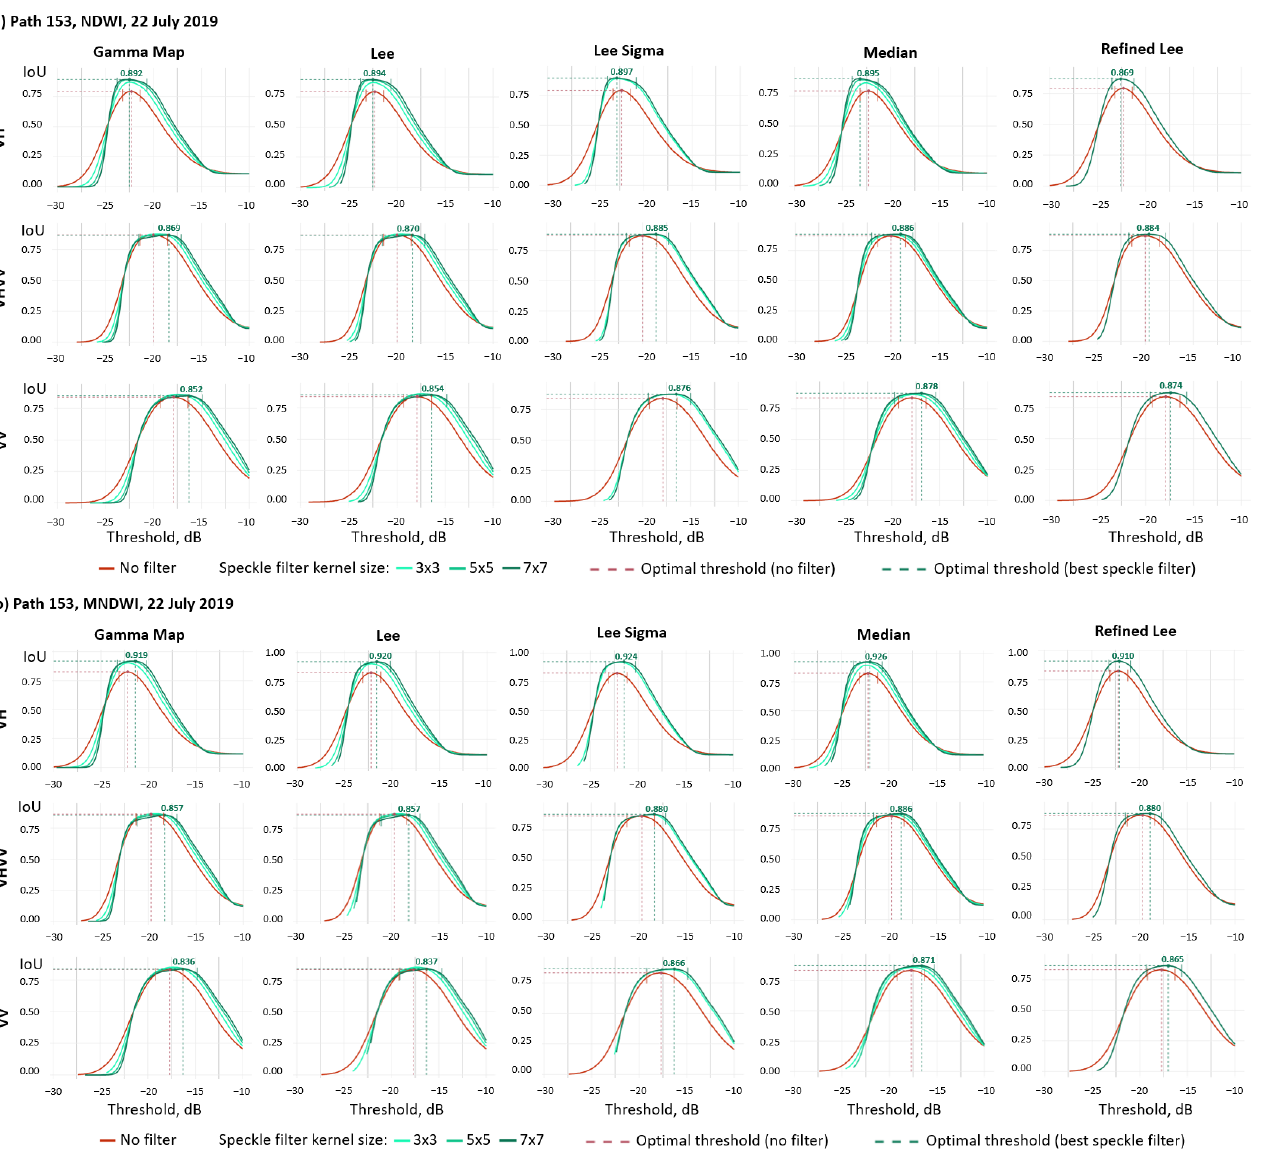
Figure 8. IoU mask similarity versus backscatter threshold: ( a ) 22 July 2019 NDWI ; ( b ) 22 July 2019 MNDWI